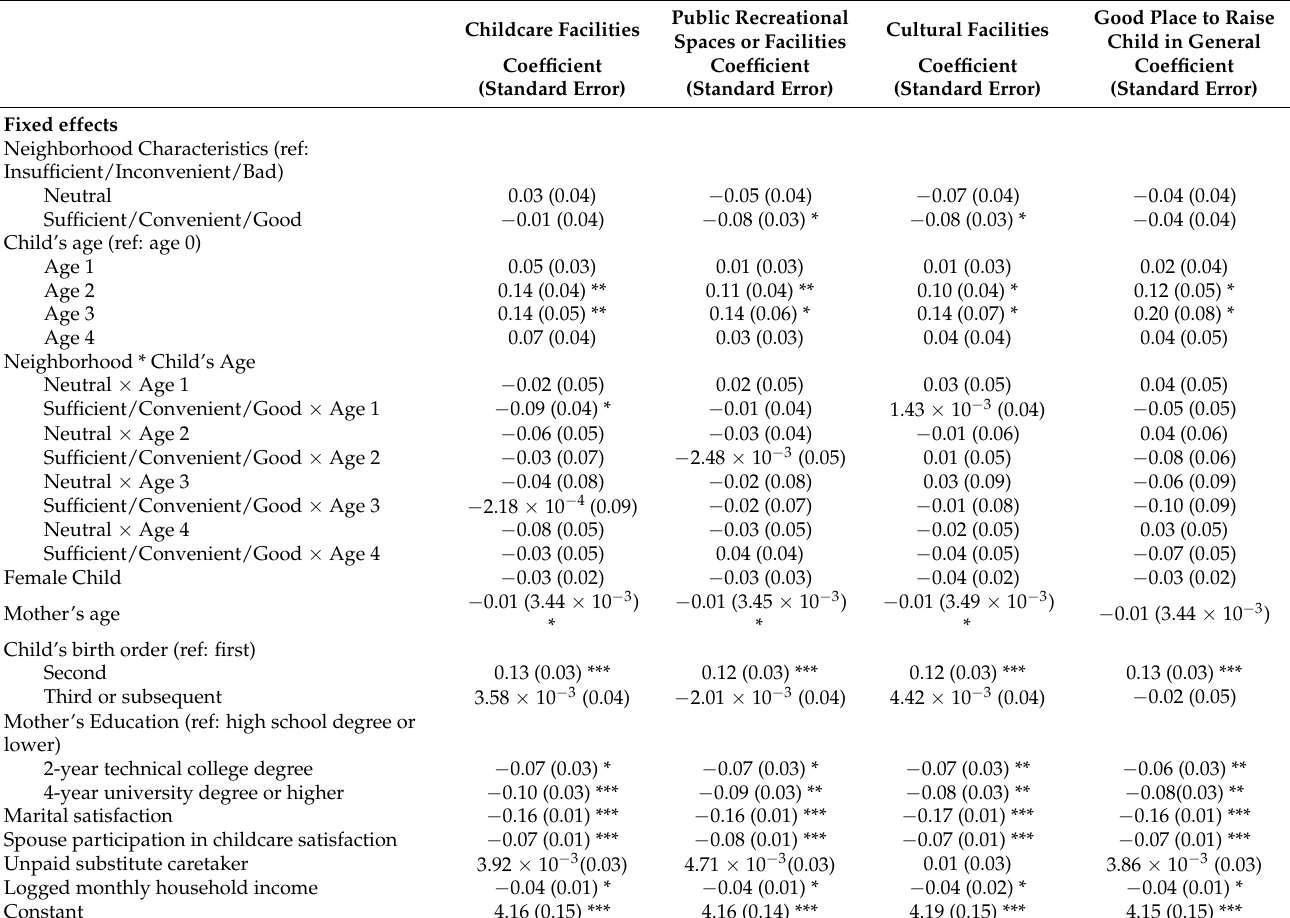
Table A1. Multilevel Mixed Effect Modeling Including Interaction Terms ( n =